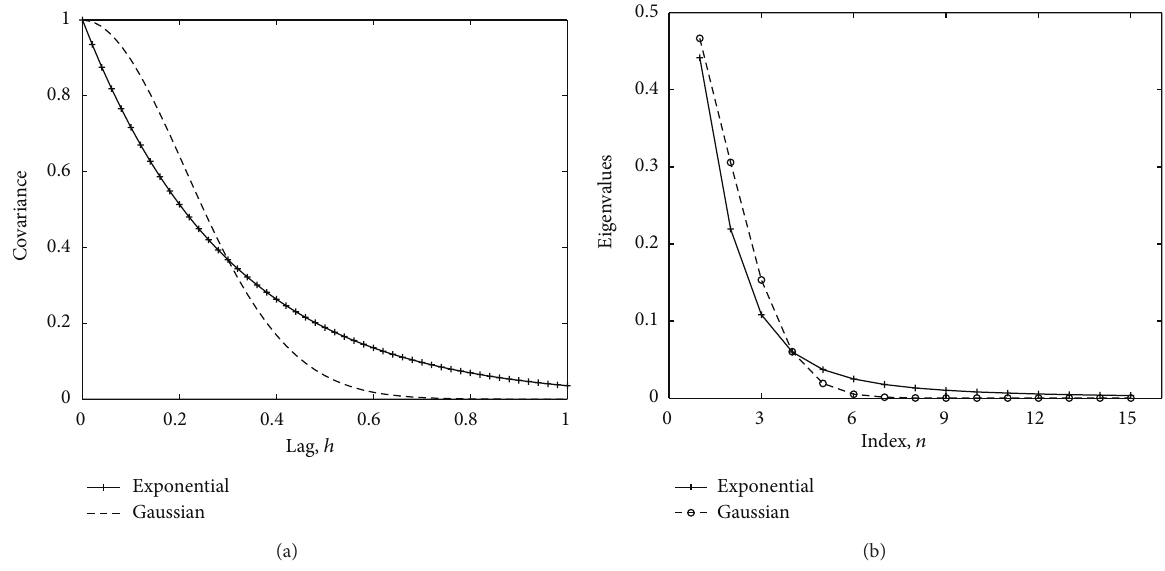
Figure 1: (a) plot of exponential (9) and Gaussian (10) covariance models as function of the lag ‖𝑥 − 𝑦‖ , with 𝜂 = 0.3 and 𝜎 = 1 . (b) first 15 eigenvalues of their KL